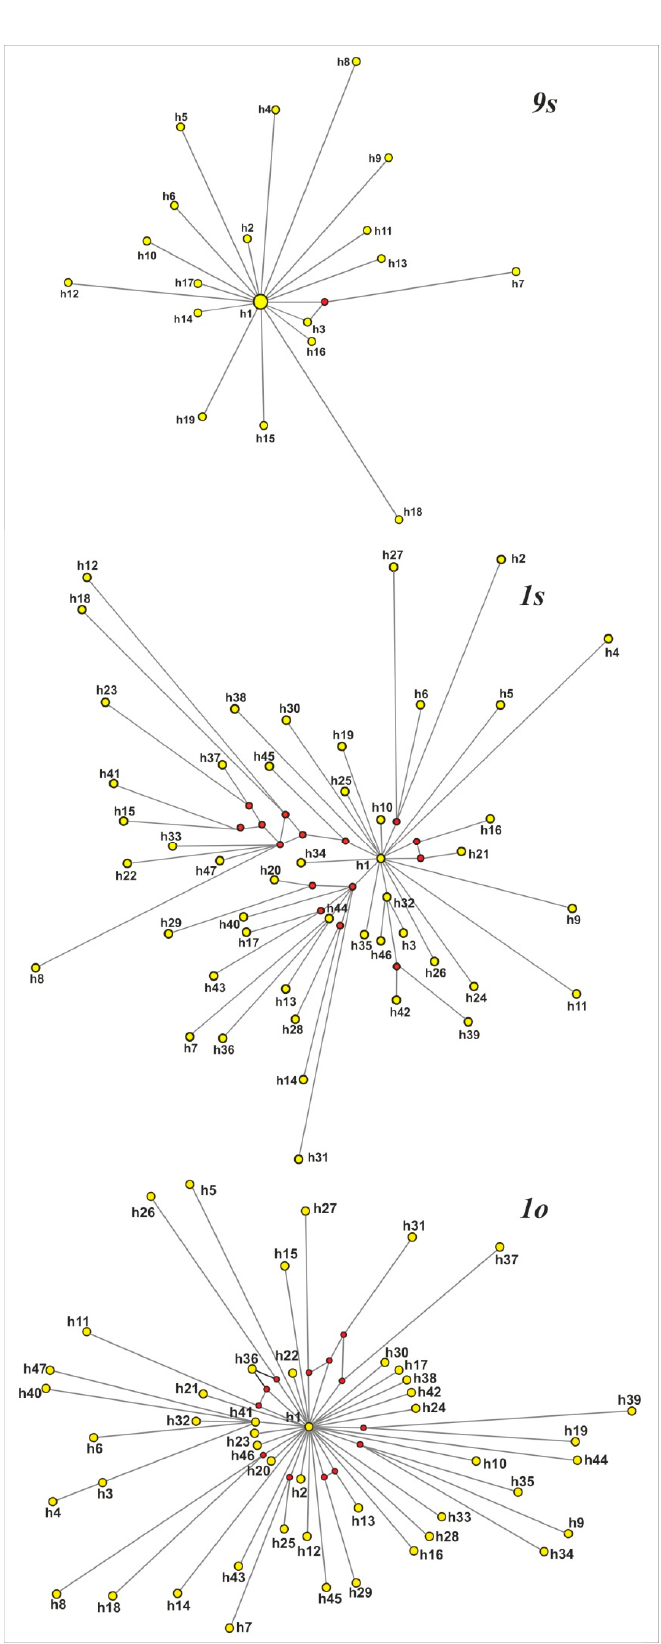
Figure 5. Phylogenetic relations of the 18S rDNA sequences in the Panax ginseng cell cultures.